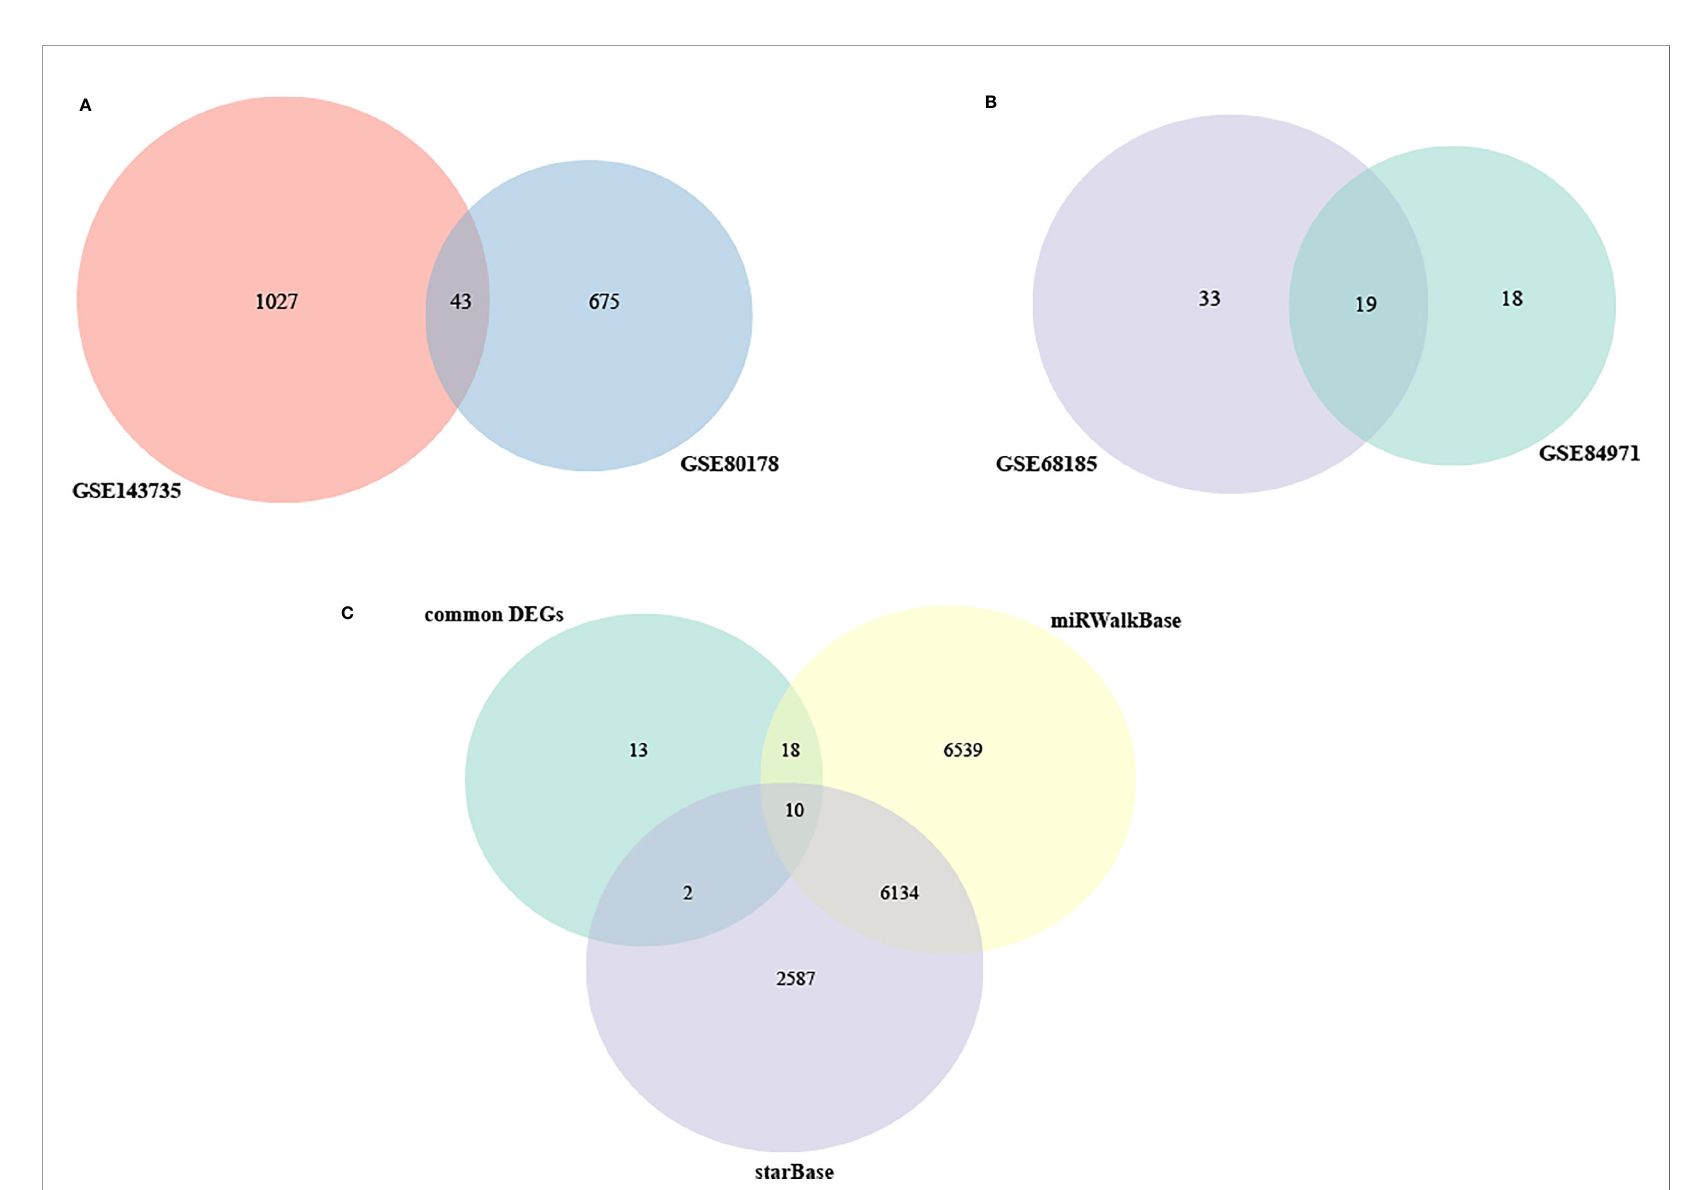
FIGURE 6 | The Venn diagram of DEGs and DEMs. (A) Venn diagram of DEGs in GSE80178 and GSE143735. (B) Venn diagram of DEMs in GSE68185 and GSE84971. (C) Venn diagram of DEMs in GSE80178, GSE143735, and